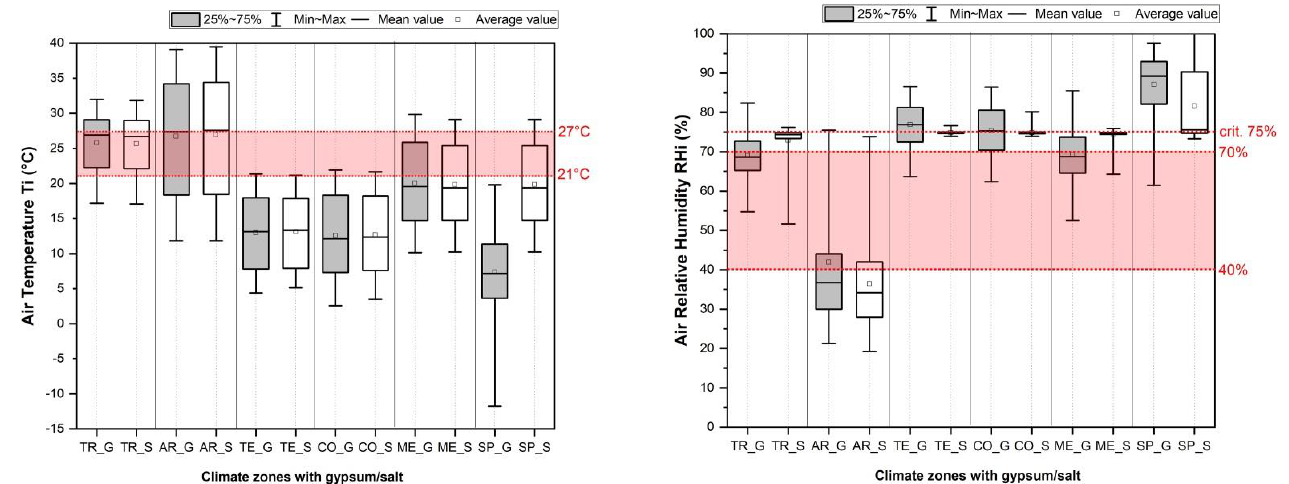
Figure 6. Simulated indoor air temperature and relative humidity for 6 climate zones (TR—Tropical, AR—Arid, TE—Temperate, CO—Continental, ME—Mediterranean, SP—Subpolar) with gypsum (G-grey box) or salt (S-white box) without HVAC. Red area – area for the most comfortable T ( ◦ C) and RH (%).